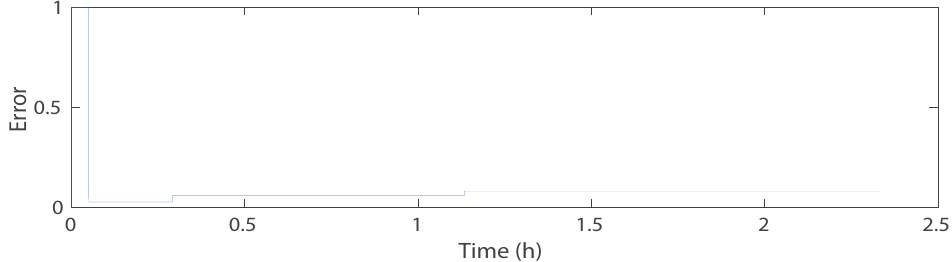
Figure 9. Results of the variable current discharge test: ( a ) The absolute error with the standard deviation between SOC ref and ˆ SOC . ( b ) The average absolute error between the SOC ref and ˆ SOC .